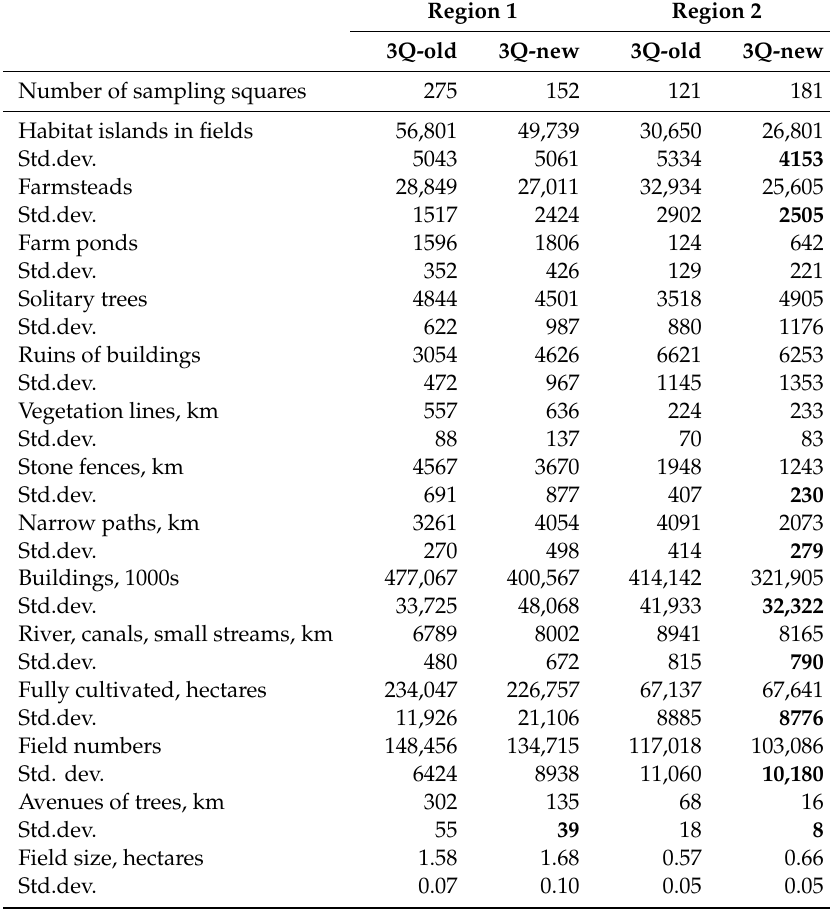
Table 2. Estimated amount (number, length or area) and standard deviation of various landscape elements in the old sample (3Q-old) and new sample (3Q-new) in Region 1, with fewer monitoring squares, and Region 2, with an increase in monitoring squares. Standard deviations of the estimates are based on bootstrapping with replacement, 2000 iterations. Bold font highlights cases with a lower std.dev. in the new sample. Data in the old sample (3Q-old) and the new sample (3Q-new) are mainly from aerial photos taken in the same